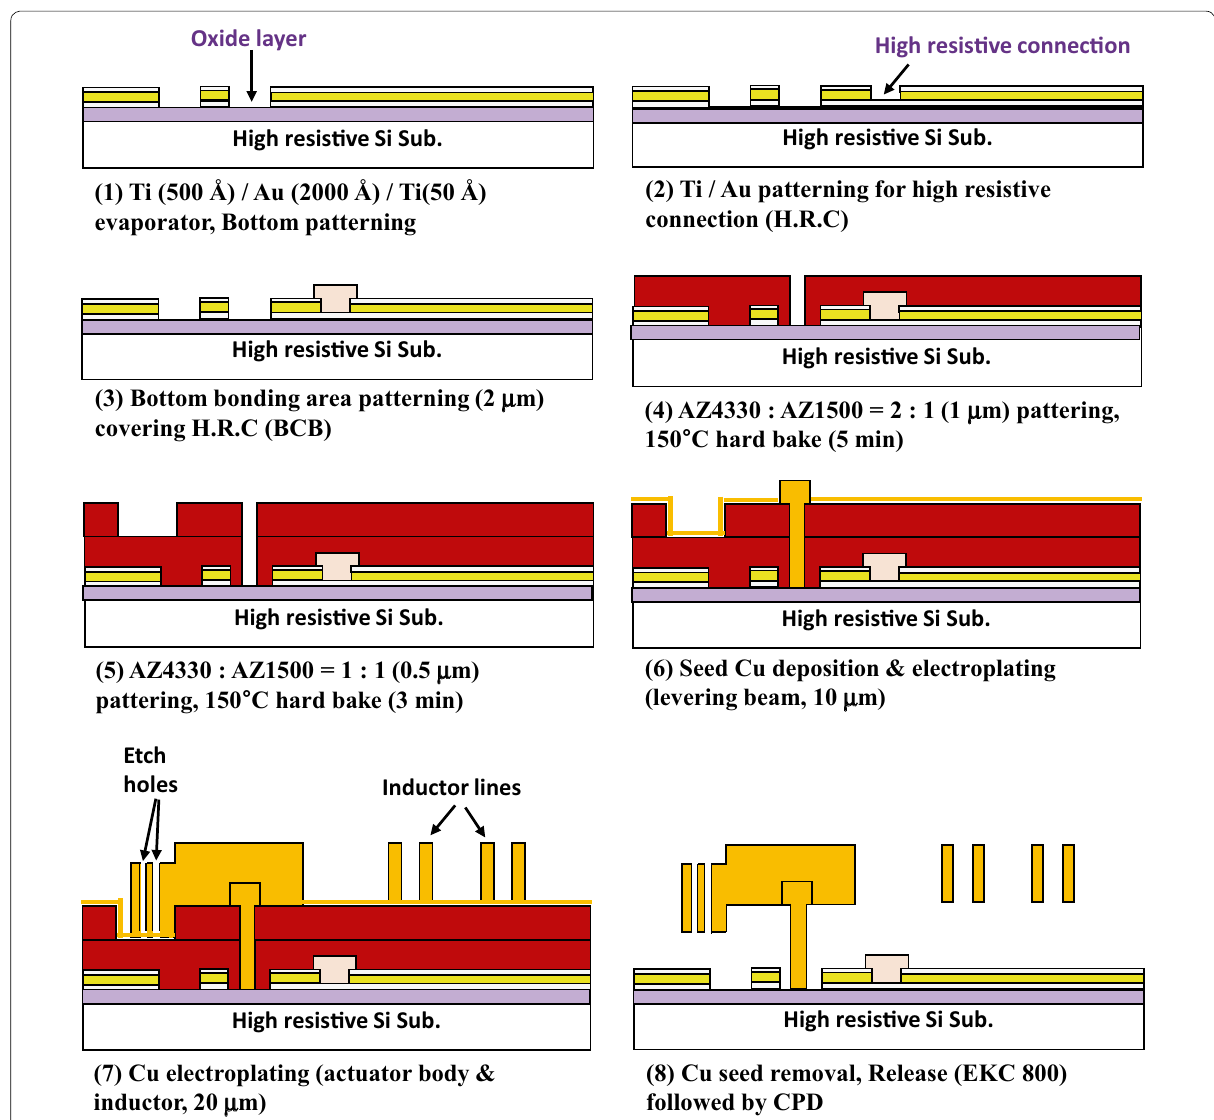
Fig. 4 Fabrication process of the proposed linear frequency‑tuned LC